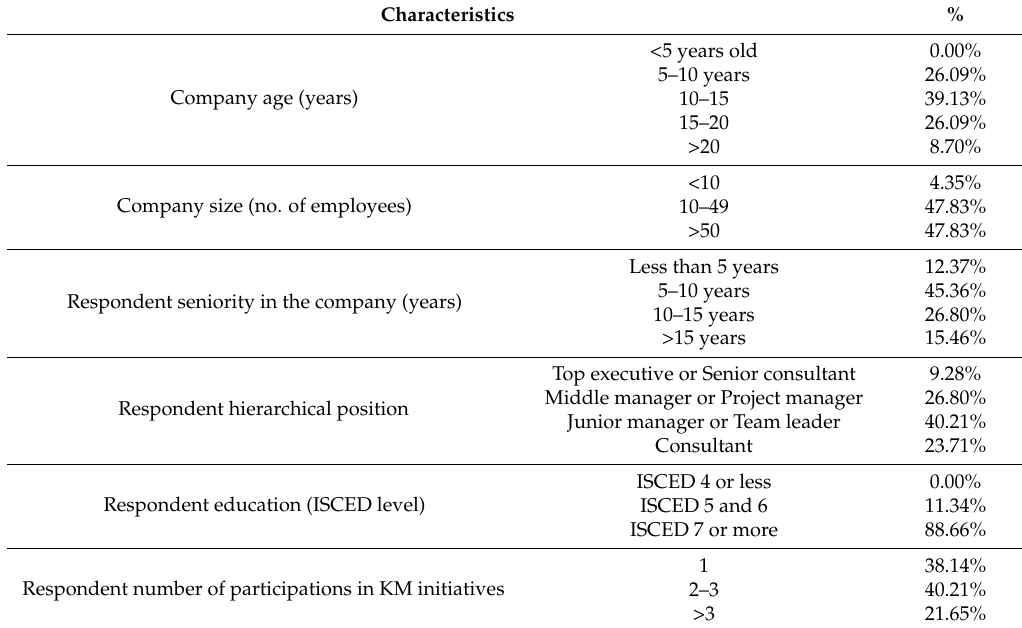
Table 1. Sample structure.